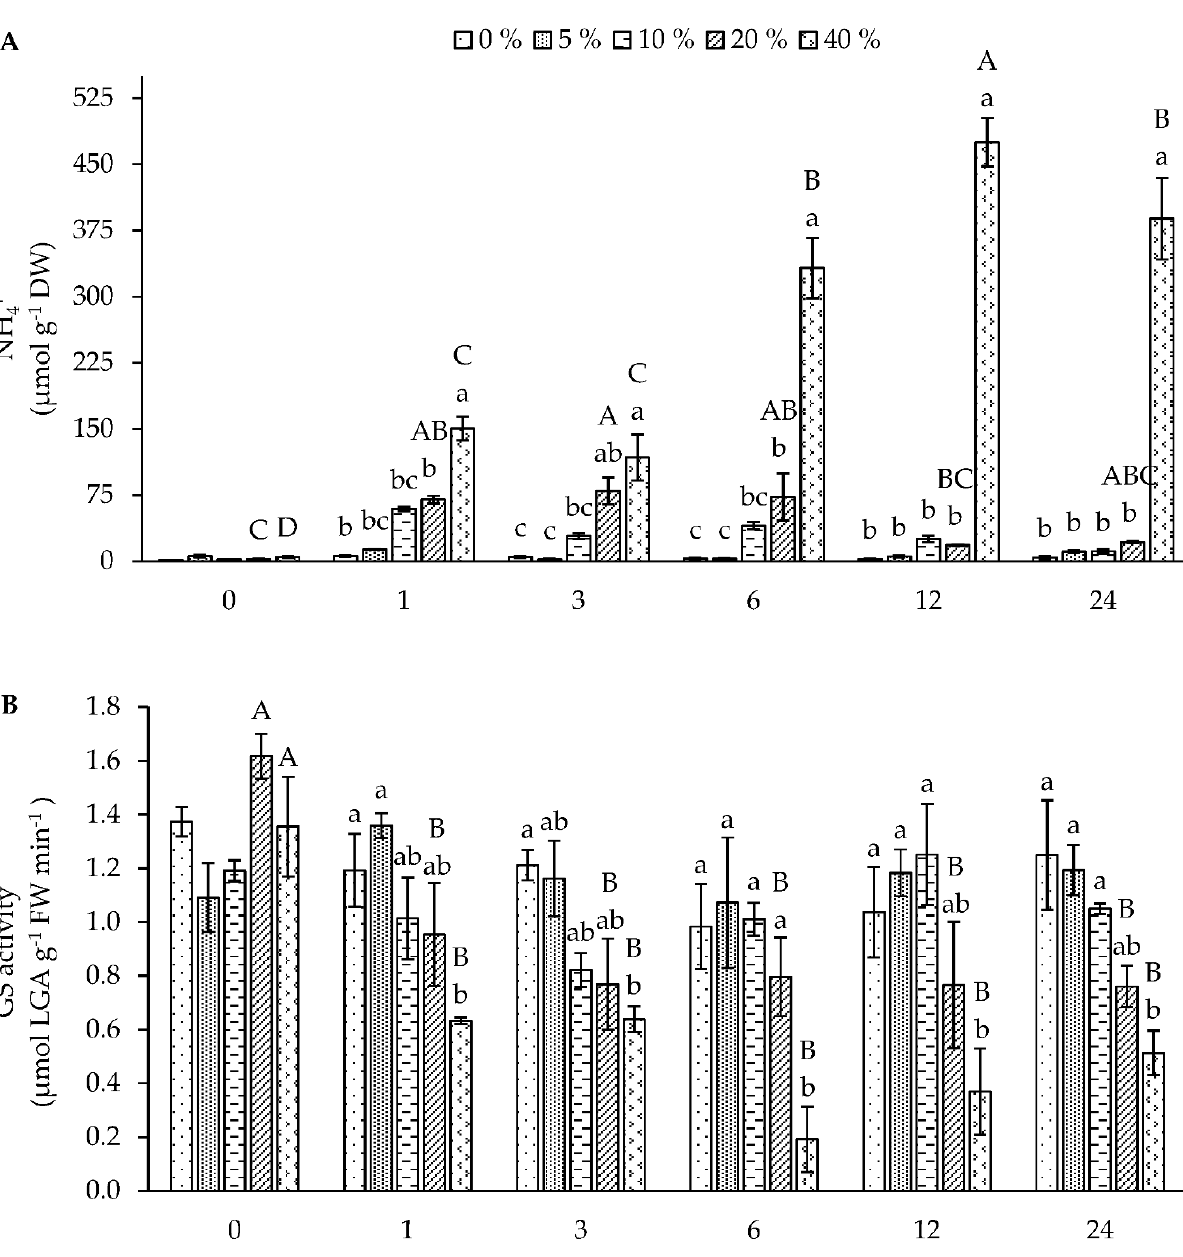
(Figure S4) decreased in the plants following foliar fertilization with 20% N treatment already at 3 HAFNf, while no difference was observed in the transpiration rate.